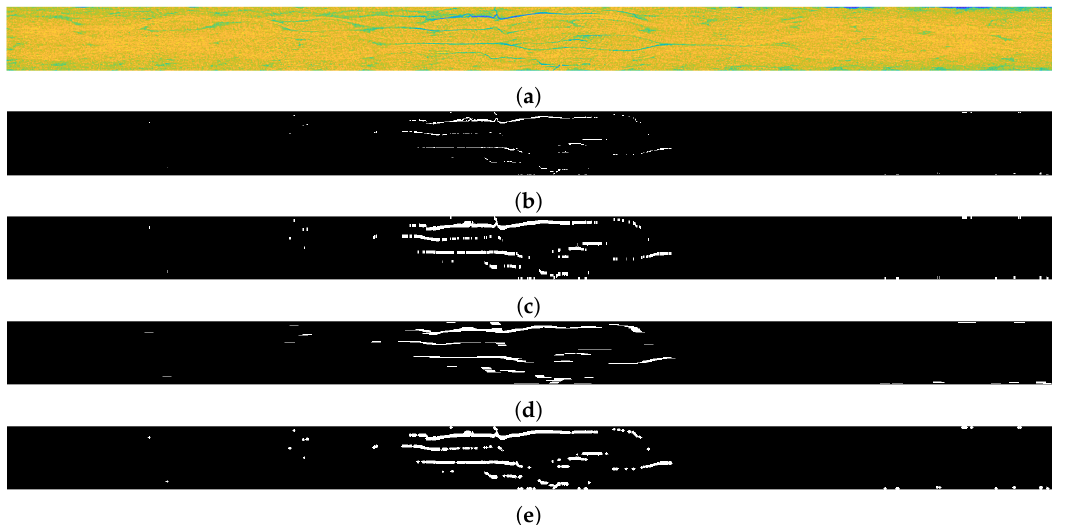
Figure 11. Processing of the results: ( a ) original CT slice; ( b ) recognized cracks; and directional expansion in the direction: ( c ) vertical; ( d ) horizontal; ( e ) diagonal.